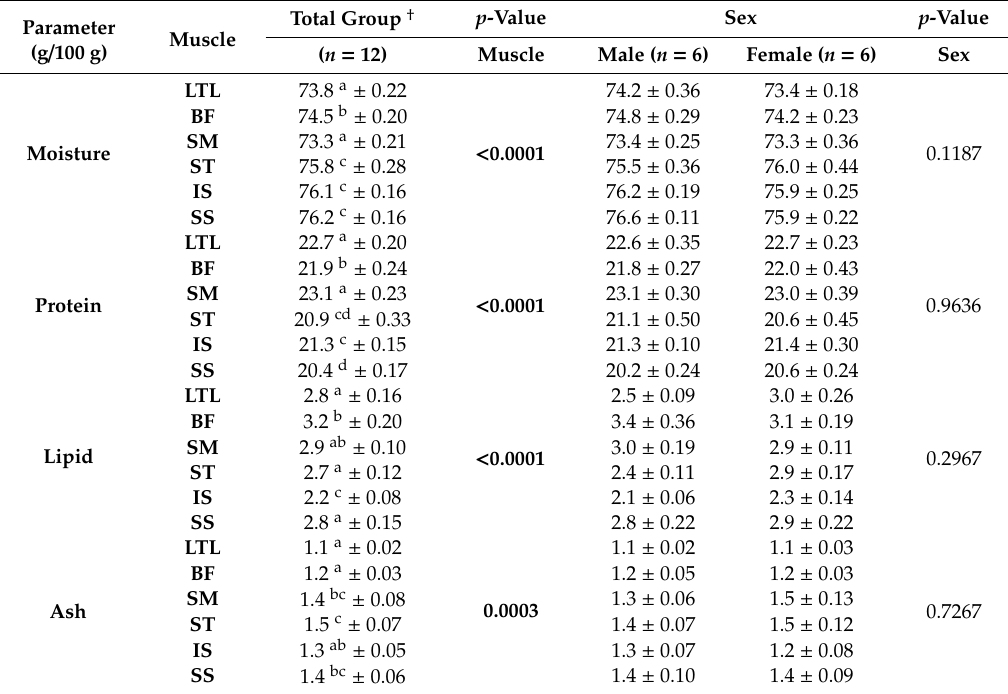
Table 1. Mean ( ± standard error) proximate composition in g / 100 g (%) of six di ff erent muscles from fallow deer ( n = 12), as influenced by muscle and